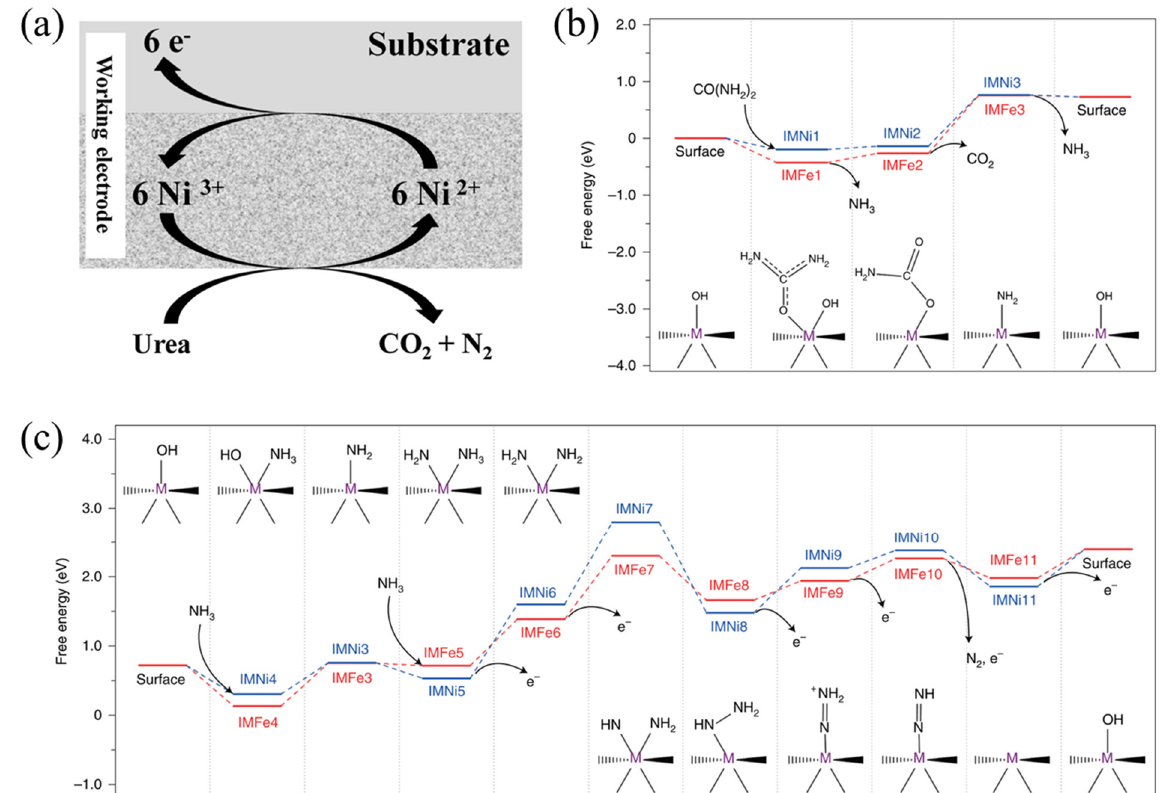
Figure 3. ( a ) Illustration of the indirect oxidation mechanism for the Ni(OH) 2 catalyst and two-stage reaction mechanism diagrams for the Ni 2 Fe(CN) 6 catalyst in ( b ) the first stage (the reaction from urea to NH 3 ) and ( c ) the second stage (the reaction from NH 3 to N 2 ). ( a ) Reprinted with permission from Ref [15]. ( b , c ) Reprinted with permission from Ref.